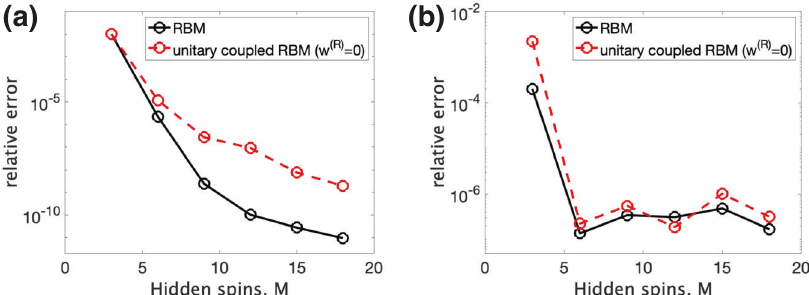
Fig. 6 Comparison between full RBM and unitary-coupled RBM states. Comparing relative errors between RBM-NQS and unitary-coupled RBM-NQS for a AFH model with h = 0 and M = N = 6, and b TFI model with h = 0.5 and M = N = 6. The de fi intion of the relative error is ∣ E exact − E rbm ∣ / ∣ E exact ∣ where rbm refers to either RBM-NQS or unitary-coupled